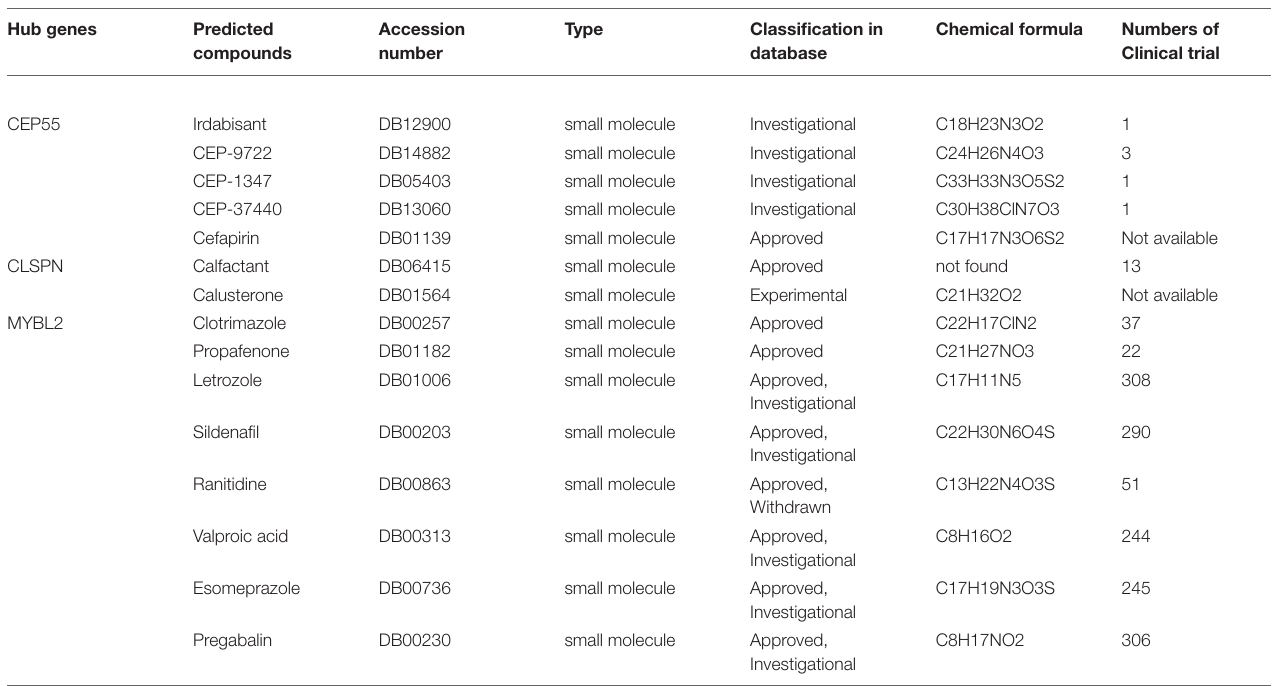
TABLE 3 | The predicted compounds target hub genes via Drugbank